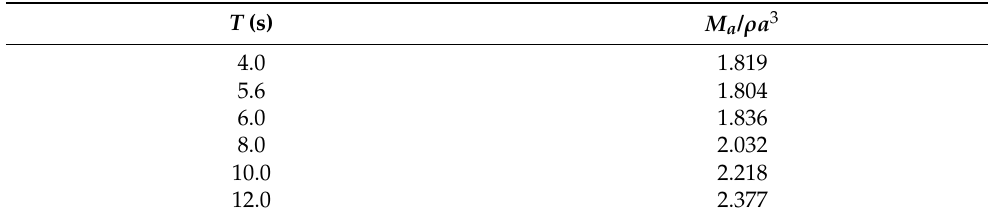
Table 1. Nondimensional M a values for different oscillation periods for a cylinder of a = 5.0 m and b / a = 1.0 placed at d = 10 m.